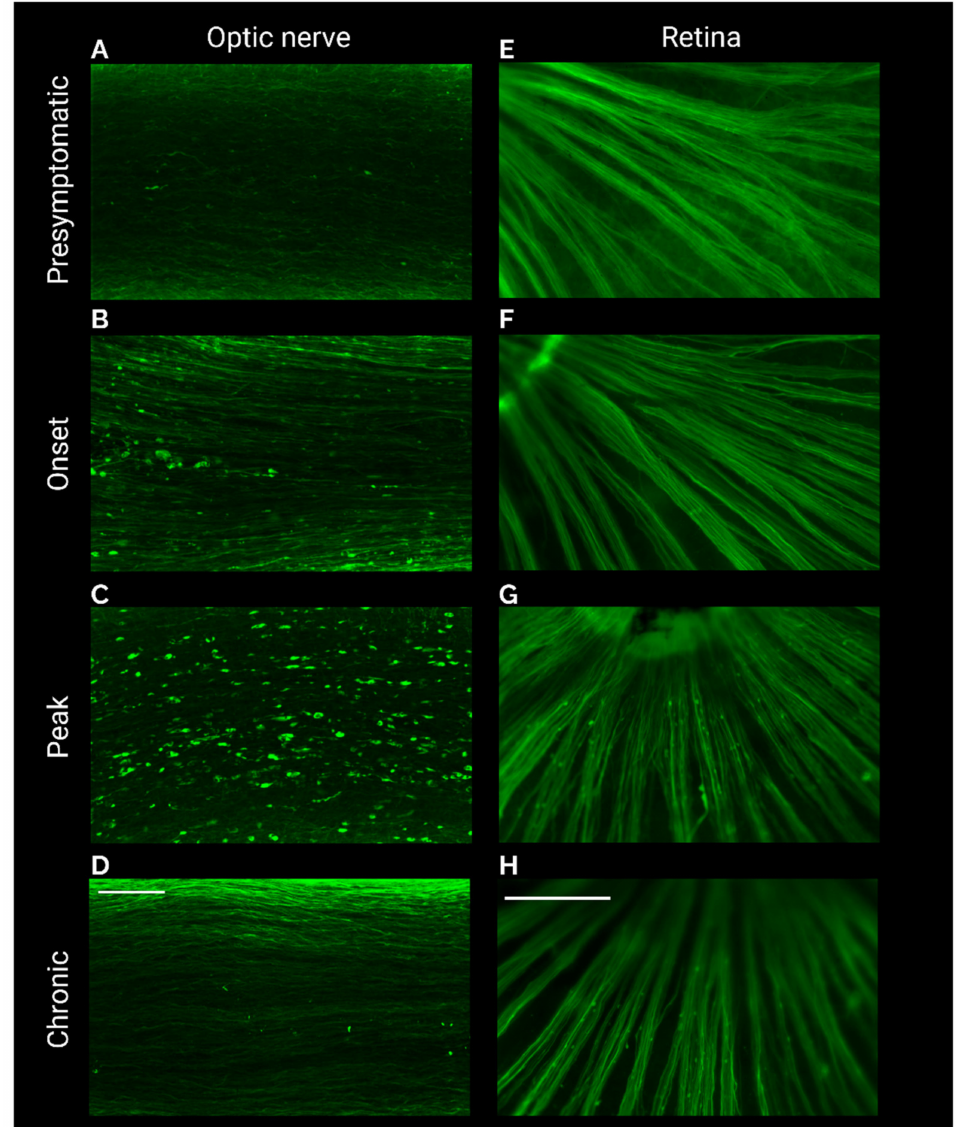
Figure 3. Neurofilament labelling of optic nerve retina reveals degeneration in EAE . ( A , C , E , G ) Max projections of neurofilament labelled optic nerves from presymptomatic ( A ), onset ( C ), peak ( E ), and chronic ( G ) stages of EAE. ( B , D , F , H ) Central retina immunostained for neurofilament from presymptomatic ( B ), onset ( D ), peak ( F ), and chronic ( H ) stages of EAE. Scale bar ( A – D ) = 100 µ m. Scale bar ( E – H ) = 500 µ